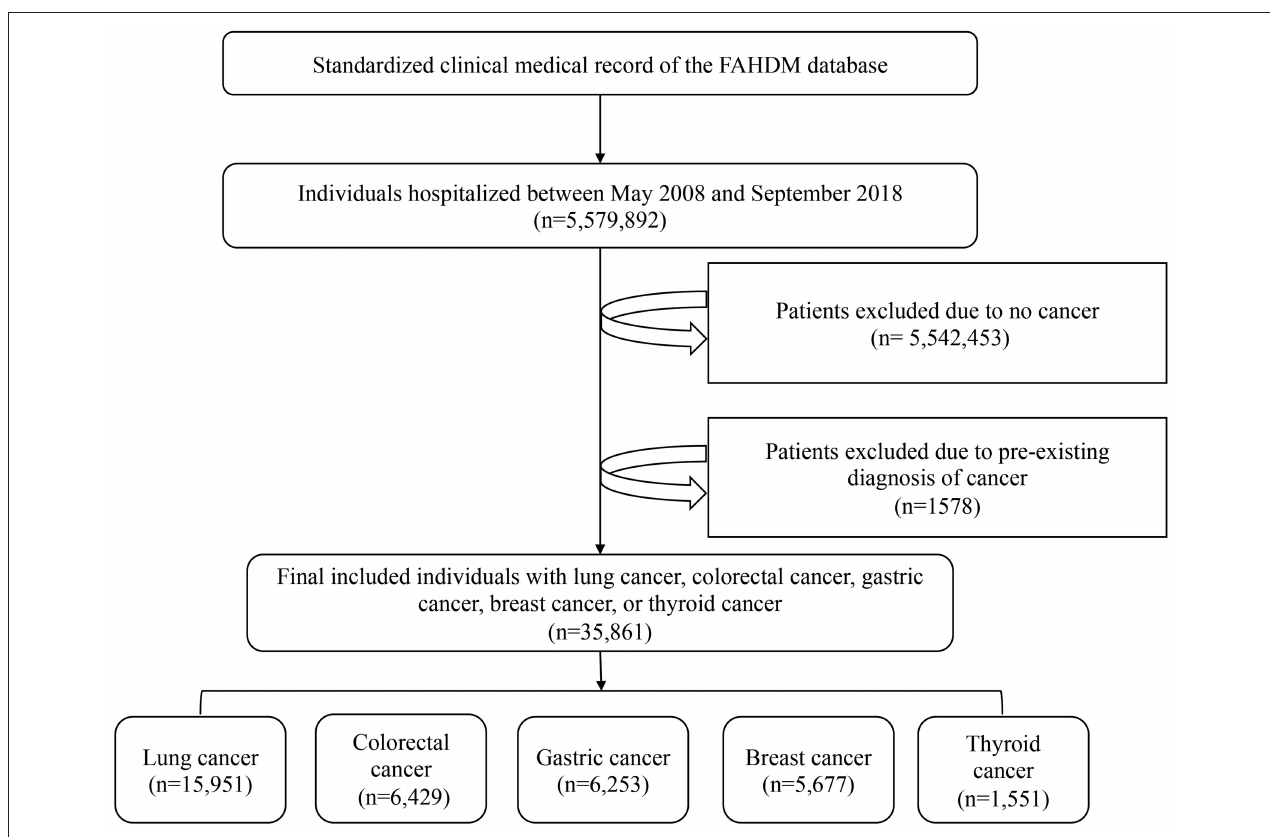
FIGURE 1 | A brief overview of the selection of study